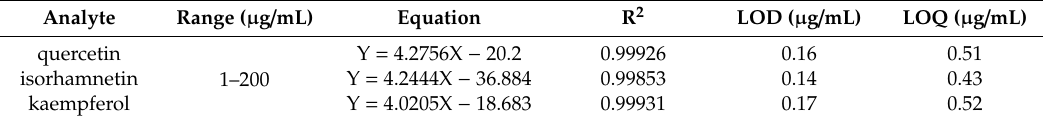
Table 1. Linearity, sensitivity and system precision (n = 9) of the proposed method.